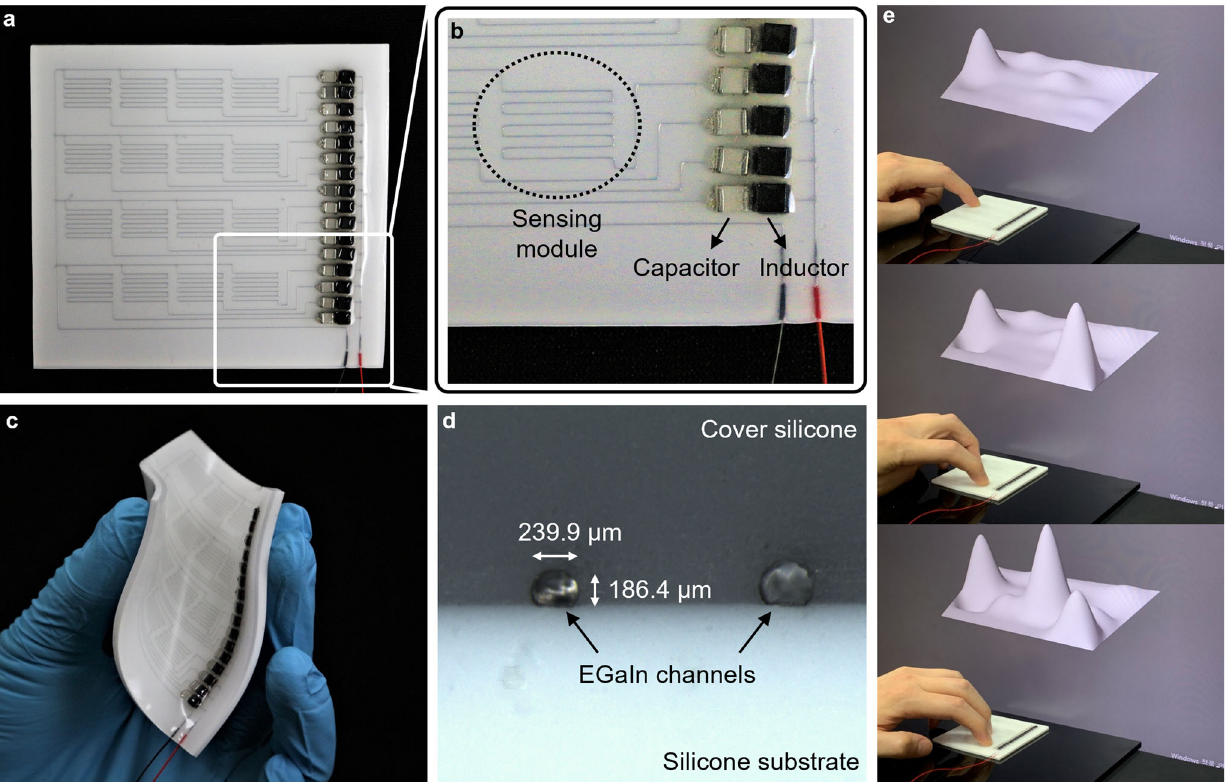
Fig. 1 Sensor con fi guration and visualization. a Prototype of a 4-by-4 soft sensor array (top view) and b a closed-up view showing the sensing module and the electronics. c Flexibility of the proposed sensor system. d Cross-section of the EGaIn microchannel with the dimension parameters. e 3D visualization of single-touch and multi-touch sensing in